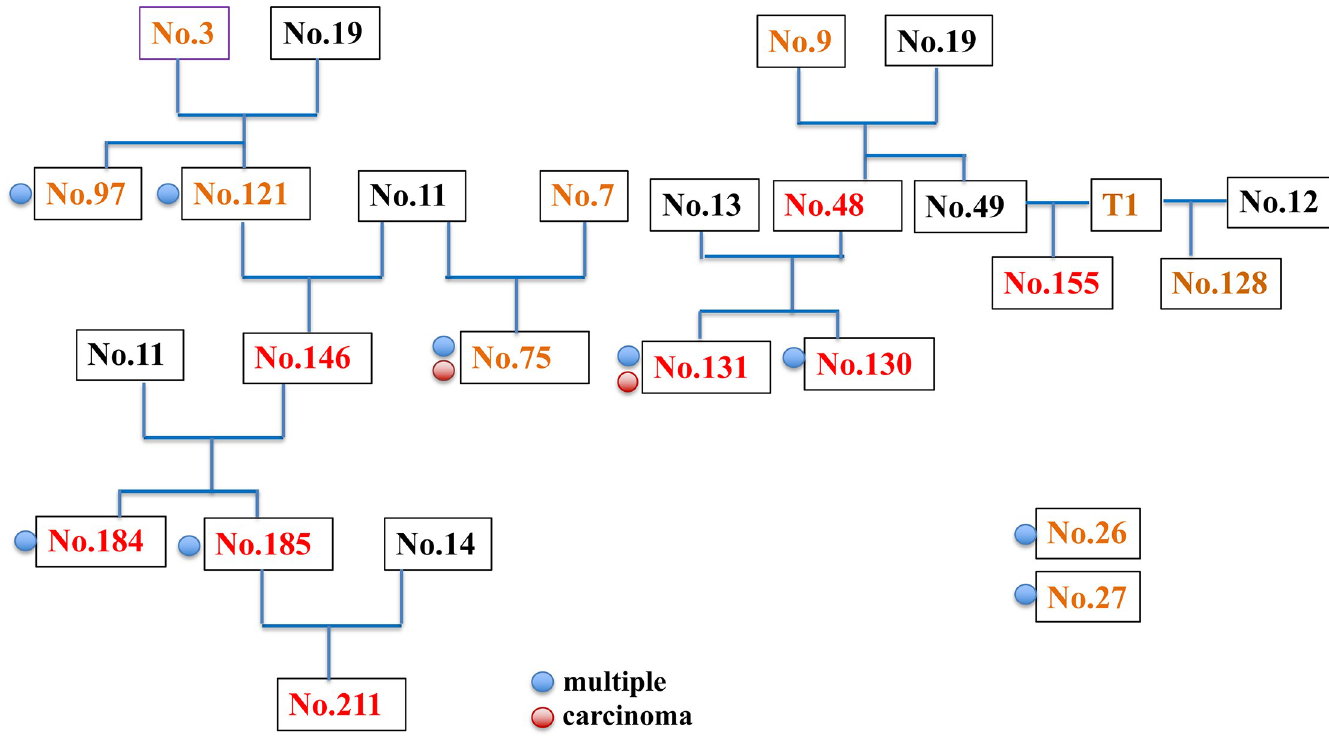
Fig 2. Lineage of tree shrew parents and offsprings. Brown color indicates female and black color indicates male tree shrew. Tree shrew numbers with red color indicate the possible familial mammary tumor and blue circle indicates the simultaneous or metachronous multiple tumors. Red circle indicates the incidence of malignant